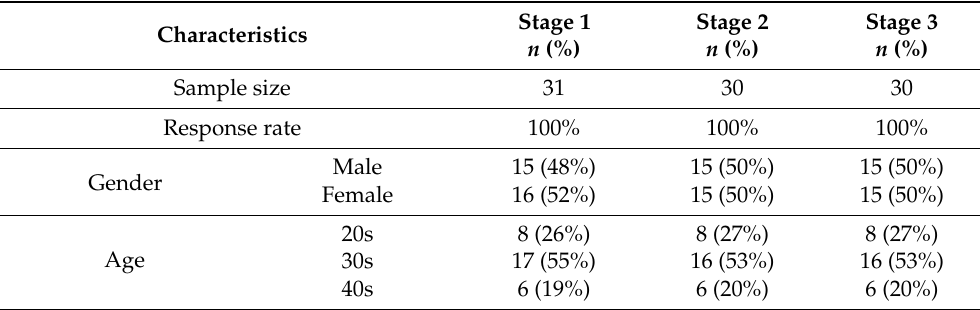
Table 1. Demographic characteristics of the participants ( N =